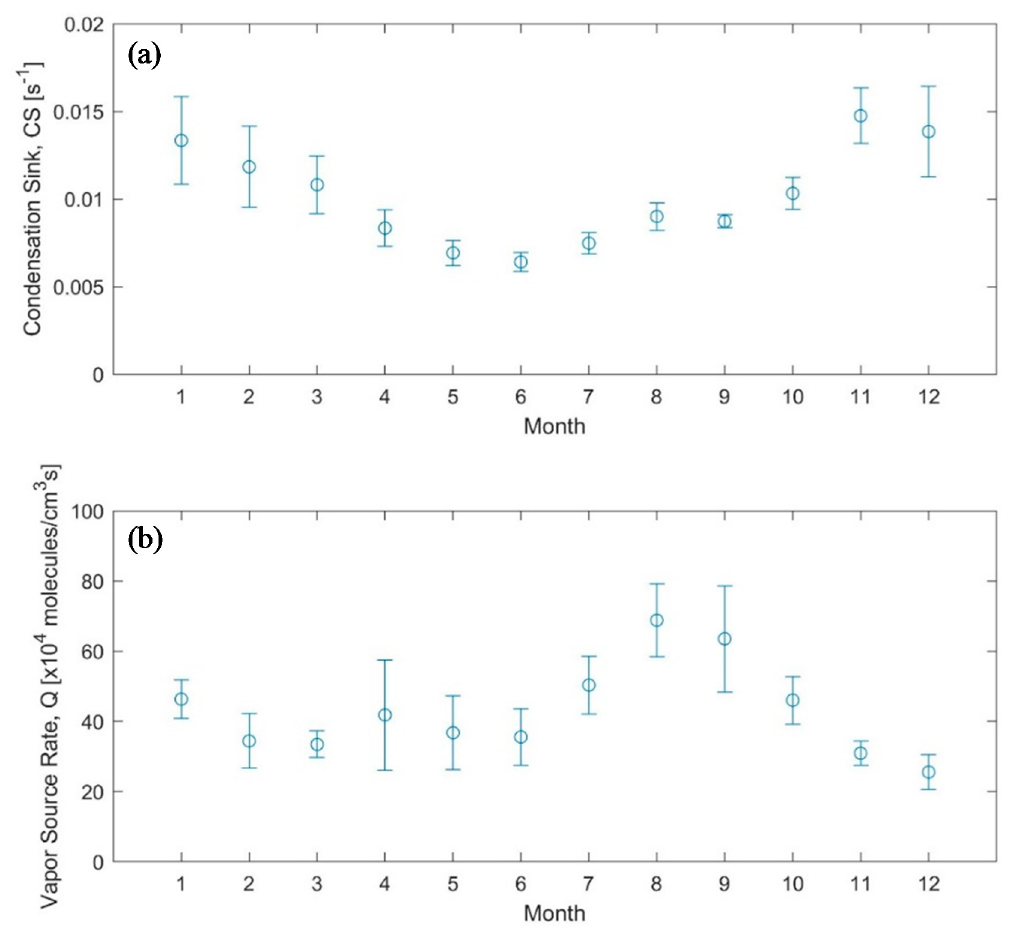
Figure 6. Yearly pattern of ( a ) the condensation sink ( CS ) and ( b ) the condensable vapor source rate ( Q ) during NPF events. The error bars represent the standard deviation.